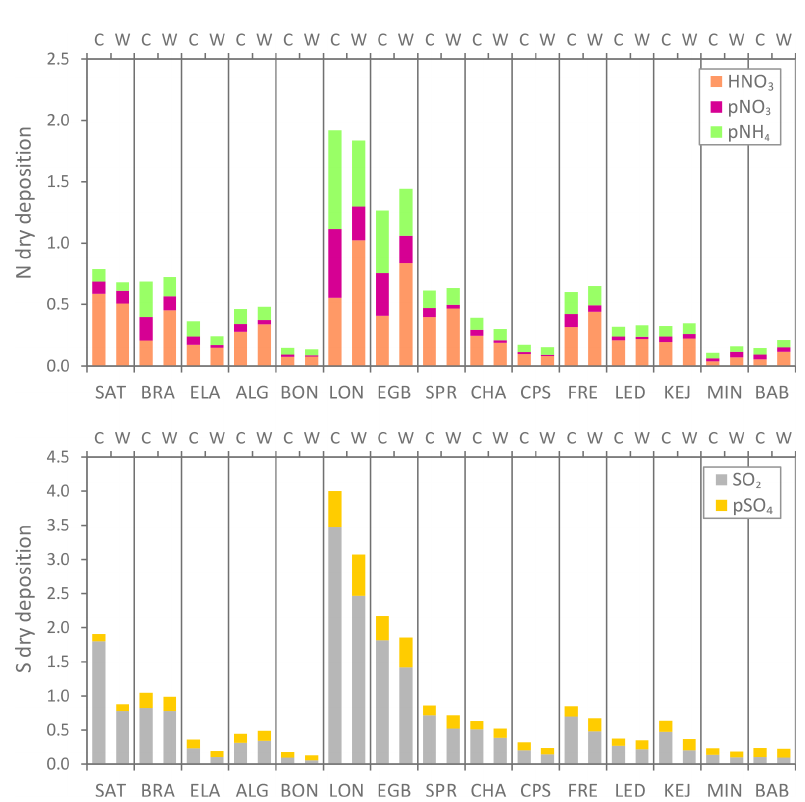
Figure 3. Mean dry deposition fluxes of N and S species (kgN or Sha − 1 yr − 1 ) during the cold (November–April) and warm (May–October) seasons during 2000–2018 at CAPMoN sites. C: cold season; W: warm season. Gaseous species: HNO 3 and SO 2 ; particulate (p) species: pNO 3 , pNH 4 , and pSO 4 . Sites are listed in order longitudinally from west (left) to east